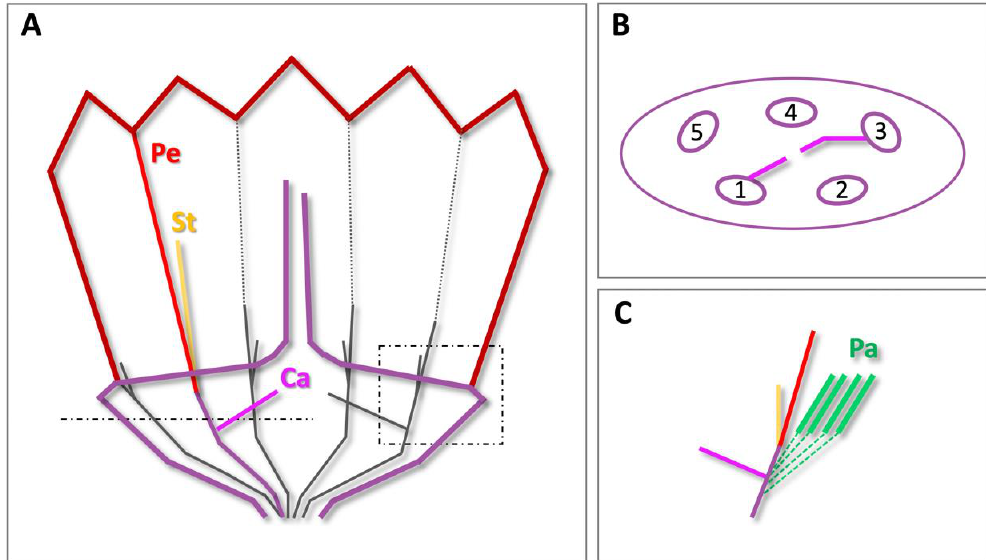
Figure 6. Summary of the vasculature in dandelion florets. The diagrams are representative of species of the Asteraceae, modified from [60]. ( A ) A longitudinal diagram showing the two splits to the carpels (Ca) and five splits to the petals (Pe) and stamens (St), with one of each bundle indicated in colour: Petal bundle (red); stamen bundle (yellow); main bundle (dark pink); carpel bundle (bright pink). Main bundles to the pappus are absent in dandelions, but capillaries to pappus parts are present in mature dandelion florets (see Figure 5D,E; Supplementary Figure S3 and Video SV2). Outer lines corolla (dark red); outer lines ovary and style (dark pink); broken line = cutting edge of the transverse diagram in ( B ); broken line box = enlargement in ( C ). ( B ) A transverse diagram showing the ovarian vasculature, with numbers denoting the five main bundles that each bifurcate to a petal and a stamen, and solid lines indicating the two bundles to the carpels, with one moved to the more central position between bundles 3 and 4 (see also Figure 5C; Supplementary Figure S5). ( C ) Capillary bundles (dashed green lines) to the pappus parts (Pa; solid green lines) and their branching from the main bundles just around where they split to the carpels.